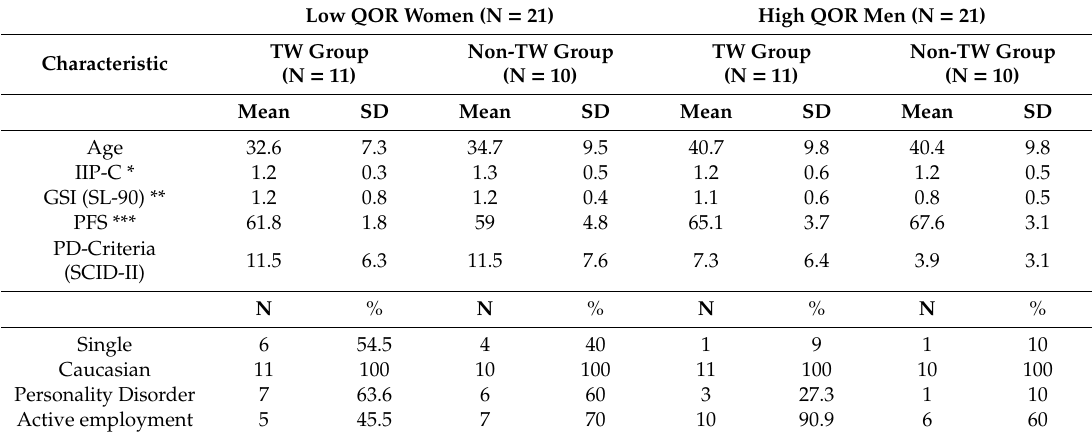
Table 2. Pre-treatment characteristics for patients receiving dynamic psychotherapy for 1 year with and without transference work. Characteristics for women / low quality of object relations (QOR) and men / high QOR are shown